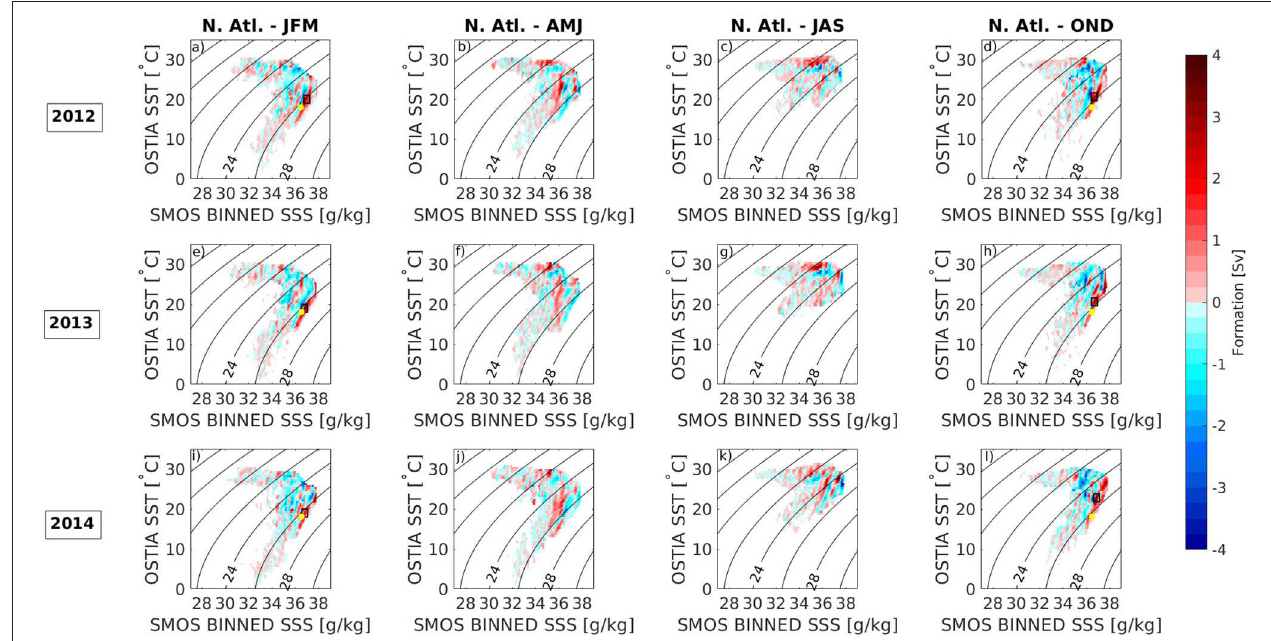
FIGURE 6 | Seasonal formation from the North Atlantic in θ –S space over the years 2012 (a–d) , 2013 (e–h) , and 2014 (i–l) . The four panels from left to right at each year indicate winter (JFM), spring (AMJ), summer (JAS), and autumn (OND), respectively. The yellow dots on the figures in the left and right most columns (JFM and OND) show the literature properties of the EDW (Worthington, 1958).